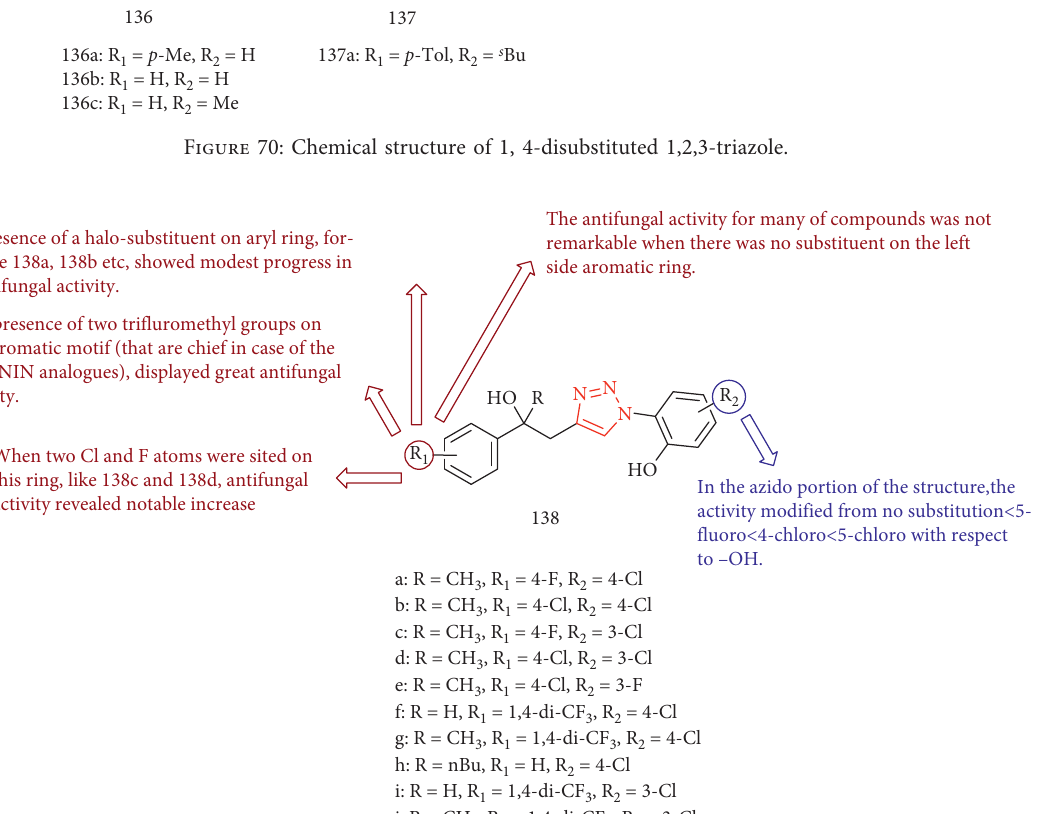
Figure 71: Chemical structure of novel